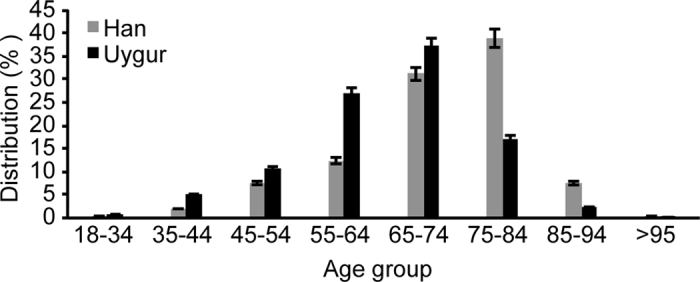
Age distribution of different ethnicity patients with AF.